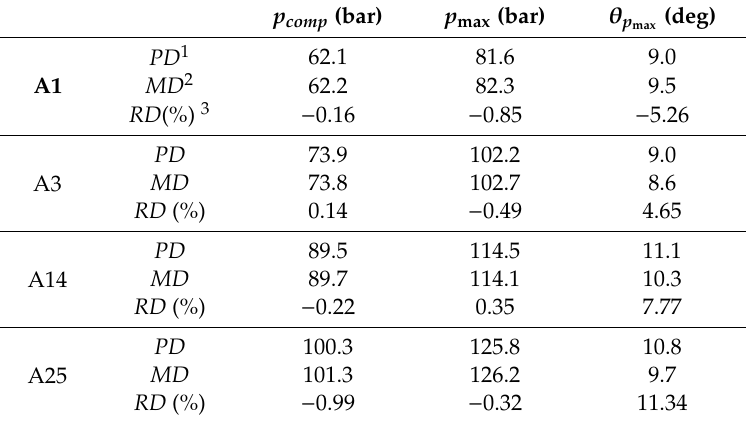
Table 5. Prediction error of the cylinder pressure analytic model.